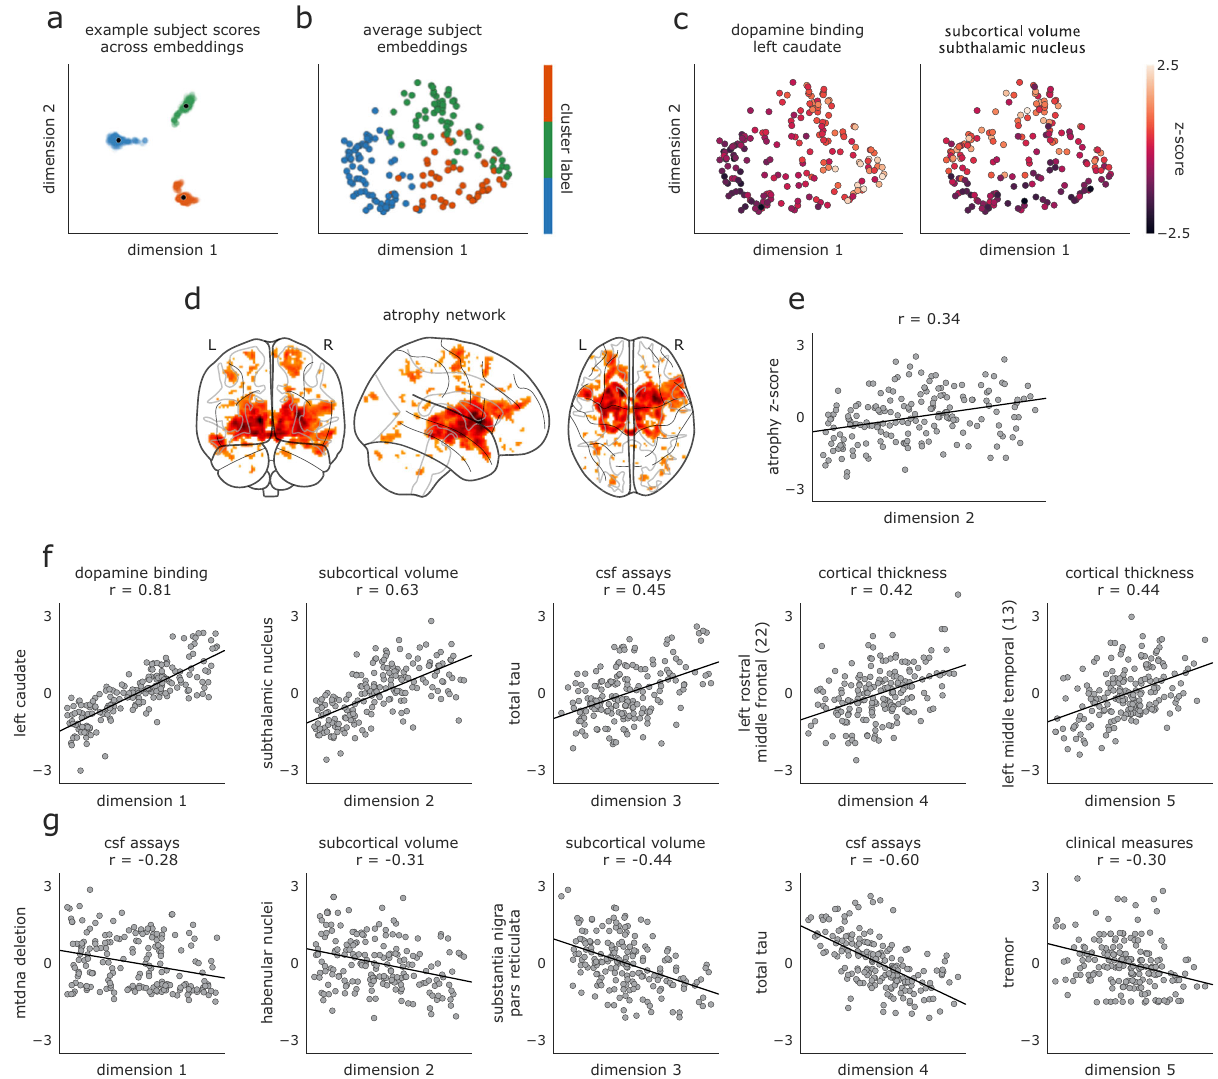
Fig. 4 Embedded patient dimensions capture relevant clinical information. a Scores of three example patients (one from each biotype) along the fi rst two embedding dimensions generated from all 1262 hyperparameter combinations retained in analyses; black dots represent average scores across all parameter combinations, which are shown for every patient in ( b ). b Scores of all patients along fi rst two dimensions of average embeddings. Colors re fl ect the same biotype af fi liation as shown in Fig. 3. c Same as ( b ) but colored by patients scores of the feature most strongly correlated with the fi rst and second embedding dimensions. Left: colors represent DAT binding scores from the left caudate ( r = 0.81 with dimension one). Right panel: colors represent subcortical volume of the subthalamic nucleus ( r = 0.63 with dimension two). d PD-ICA atrophy network from 11 , showing brain regions with greater tissue loss in PD patients than in age-matched healthy individuals. e PD atrophy scores, calculated for each patient using the mask shown in ( e ), correlated with subject scores along the second embedded dimension shown in ( a – c ). f , g Features with the most positive ( f ) and negative ( g ) associations to the fi ve embedding dimensions. Y -axes are presented as z-scores; x -axes are dimensionless units derived from the diffusion embedding